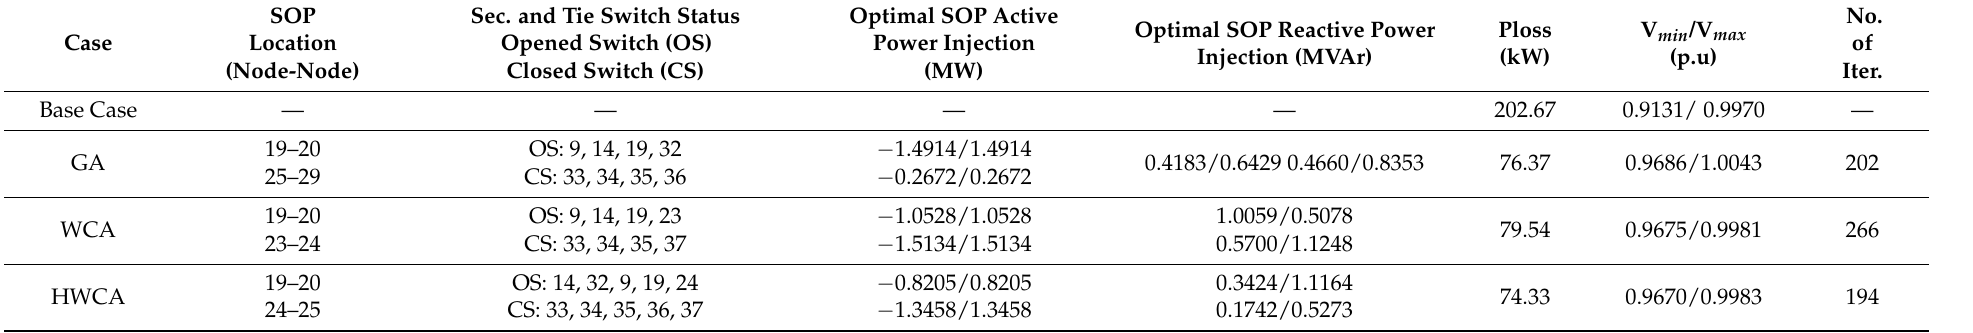
Table 5. Compared numerical results of HWCA for case 7 with WCA and GA for the 33-node system.